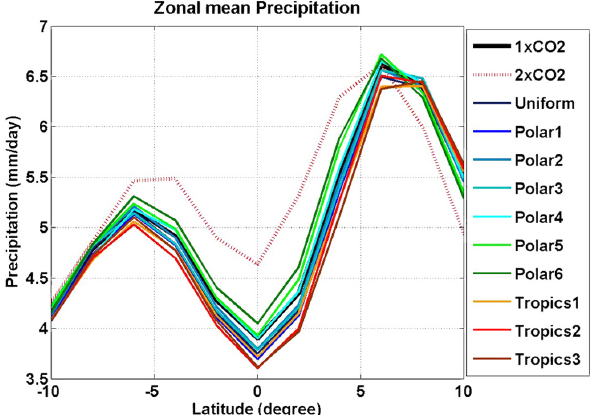
Figure 7. Zonal mean precipitation over the globe. The position of intertropical convergence zone (ITCZ) remains the same in all the geoengineering cases. The zonal mean precipitation decreases monotonically over the equator as the global mean radiative forcing increases. Results shown are averages of the last 30 years of 60-year